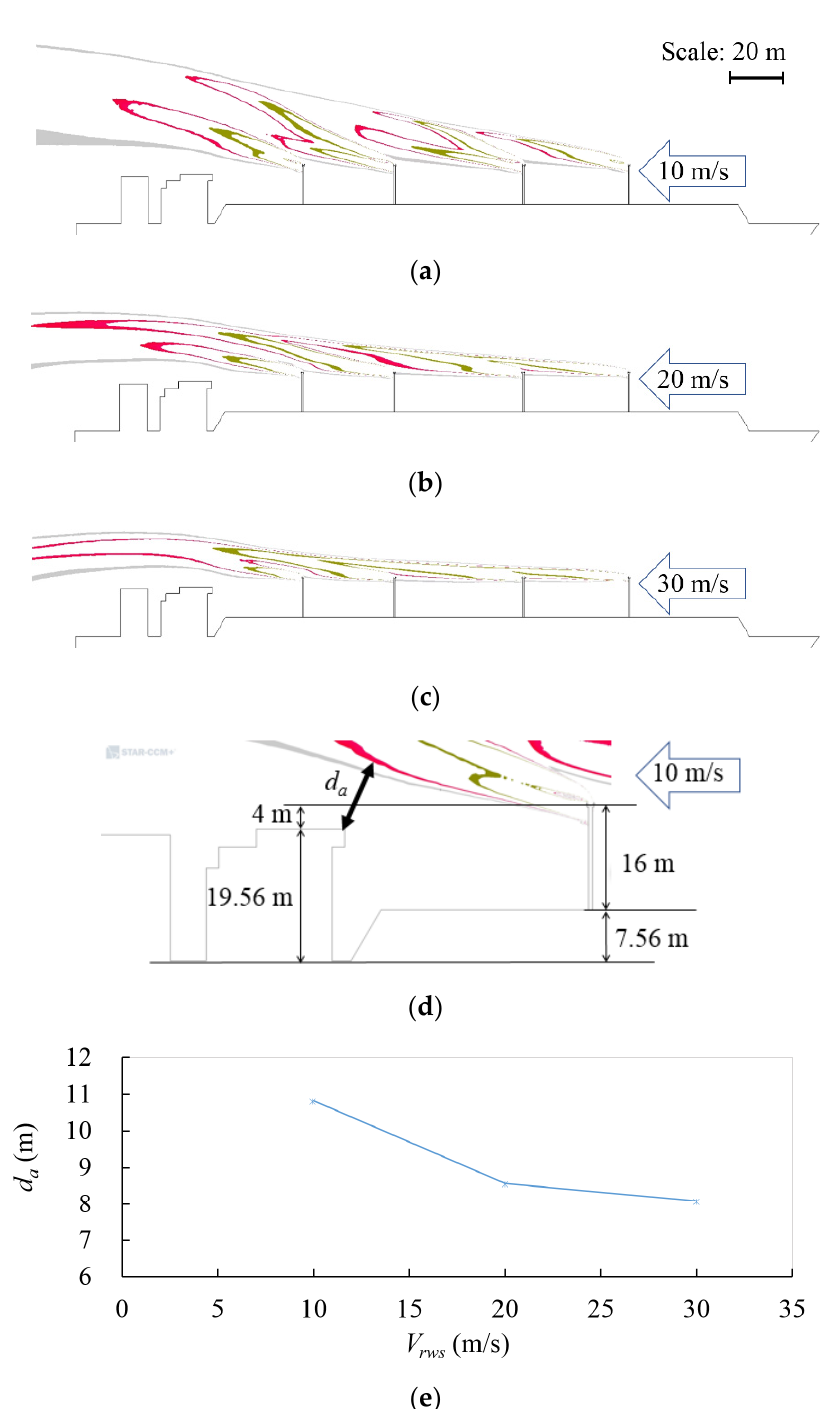
Figure 5. Contour lines of the flammability limits (FL) based on the relative wind speed ( V rws ): Around the whole ship at a relative wind speed of ( a ) 10 m/s; ( b ) 20 m/s; ( c ) 30 m/s; ( d ) near the inhabitable area at 10 m/s; and ( e ) approximate minimum distances ( d a ) of FZ from the steer room.